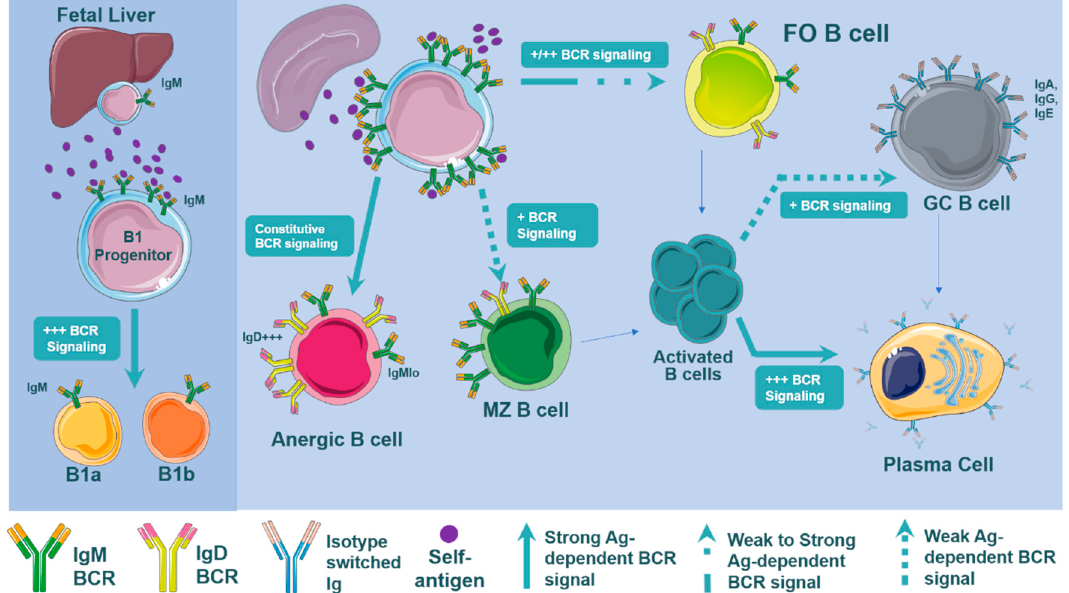
Figure 1. B cell development is dependent on B cell signal strength. Signaling through the B cell receptor (BCR) after (self)antigen recognition drives B cell differentiation through all stages of B cell development. Differentiation of B cells into B1, MZ, and FO B cells is mediated by positive and negative selection of BCR binding to antigens. B1 development is driven by strong BCR-derived signals. The spleen facilitates maturation of transitional IgM+IgD+ B cells to mature naïve MZ or FO B cells through negative selection: testing the autoreactiveness of the mature BCR. At this stage of maturation, highly reactive BCRs result in constitutive BCR signaling and fail to mature, instead, generating anergic B cells with an elevated surface IgD:IgM ratio. Transitional B cells that facilitate weak BCR signals preferentially differentiate to MZ B cells. In contrast, differentiation into FO B cells can occur with very weak or moderately strong BCR signals. The next stage of B cell development occurs after antigen binding and B cell activation. Weaker BCR signaling of activated B cells facilitates GC formation before becoming long lived plasma cells, while strong BCR signaling directs B cells to differentiate directly into short lived plasma cells. Surface expression levels of IgM and IgD and the types of antigen that are encountered mediate the activation of B cells and subsequent terminal differentiation.